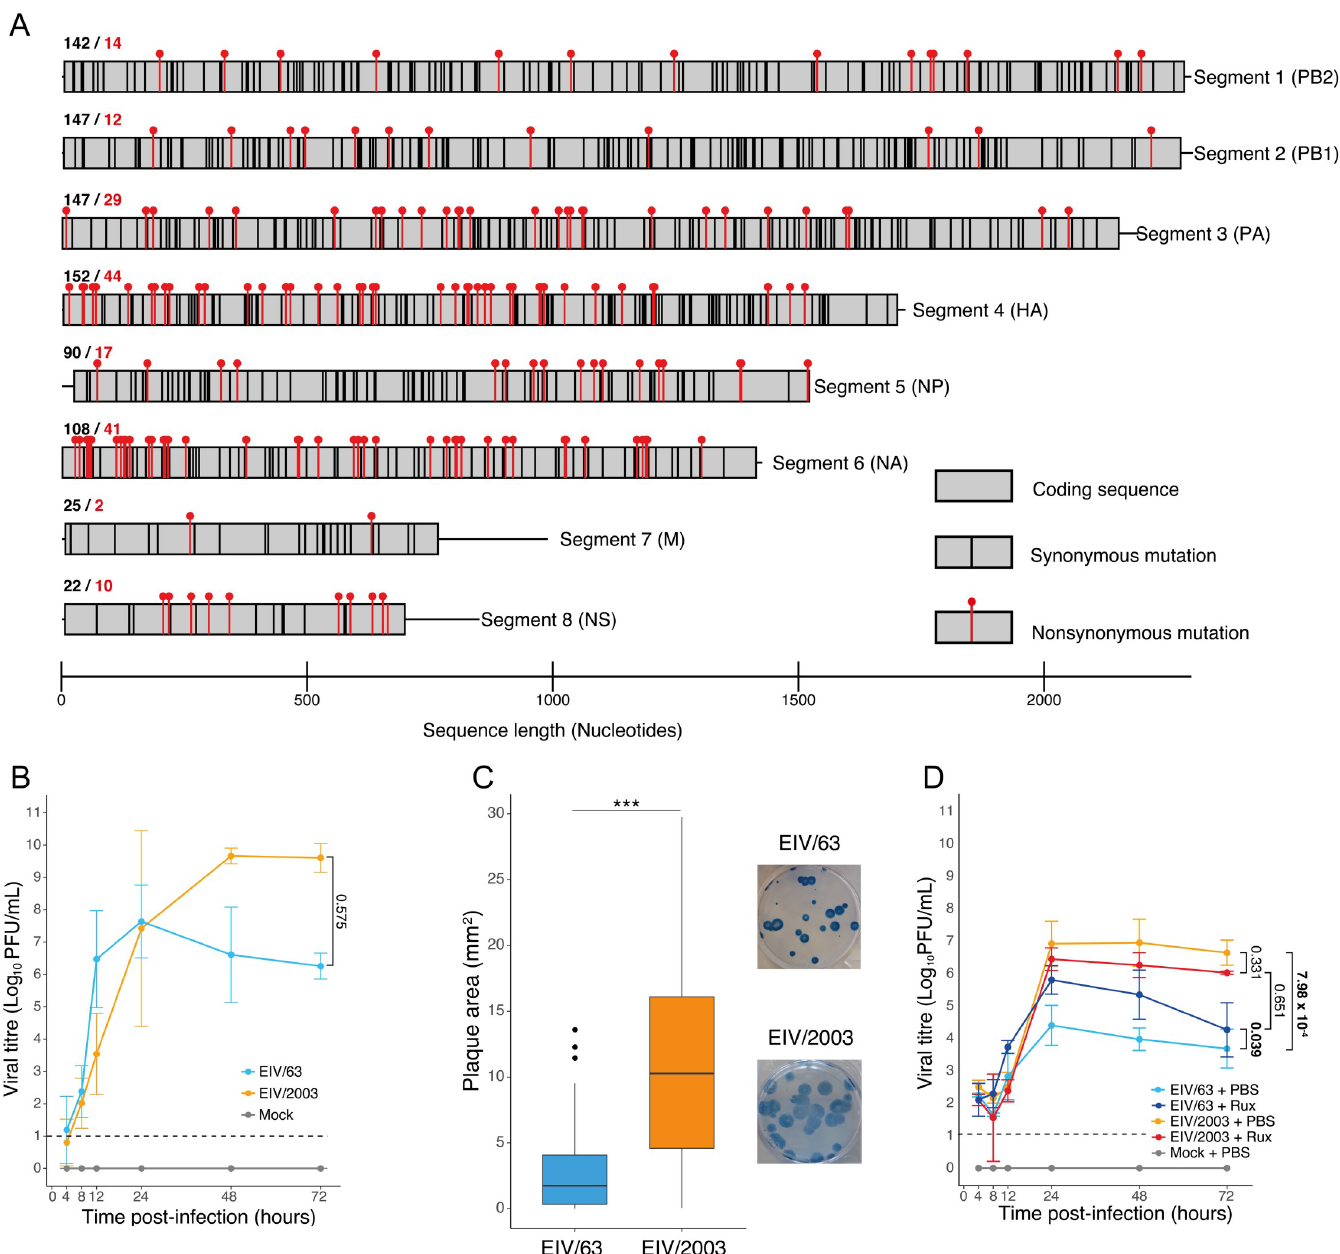
Fig 1. In vitro characterisation of H3N8 EIVs. (A) Comparison of EIV/63 and EIV/2003 coding sequences (CDS). The main protein CDS and associated polymorphisms among EIV/63 and EIV/2003 are shown as grey boxes. Black and red bars indicate synonymous and nonsynonymous mutations, respectively. The total number of synonymous and non-synonymous mutations per segment is shown above each segment in black and red, respectively. (B) Growth kinetics of EIV/63 and EIV/2003 in MDCK cells. (C) Plaque phenotype of EIV/63 and EIV/2003 in MDCK cells at 48 hpi. (D) Growth kinetics of EIV/63 and EIV/2003 in E.Derm cells with or without ruxolitinib treatment. Cyan and orange lines represent EIV/63 and EIV/2003 in the absence of ruxolitinib, respectively. Blue and red lines represent EIV/63 and EIV/2003 in the presence of ruxolitinib, respectively. Non-infected controls are shown in grey. Viral titres are represented as the mean ± SD. The limit of detection of plaque assays is shown as a black dashed line. Significant p-values are shown in bold and were calculated using generalized linear mixed-effects models. Infections were performed three times independently and each independent experiment consisted of three technical repeats. In panel C, 100 plaques per condition were measured and statistical significance assess using student